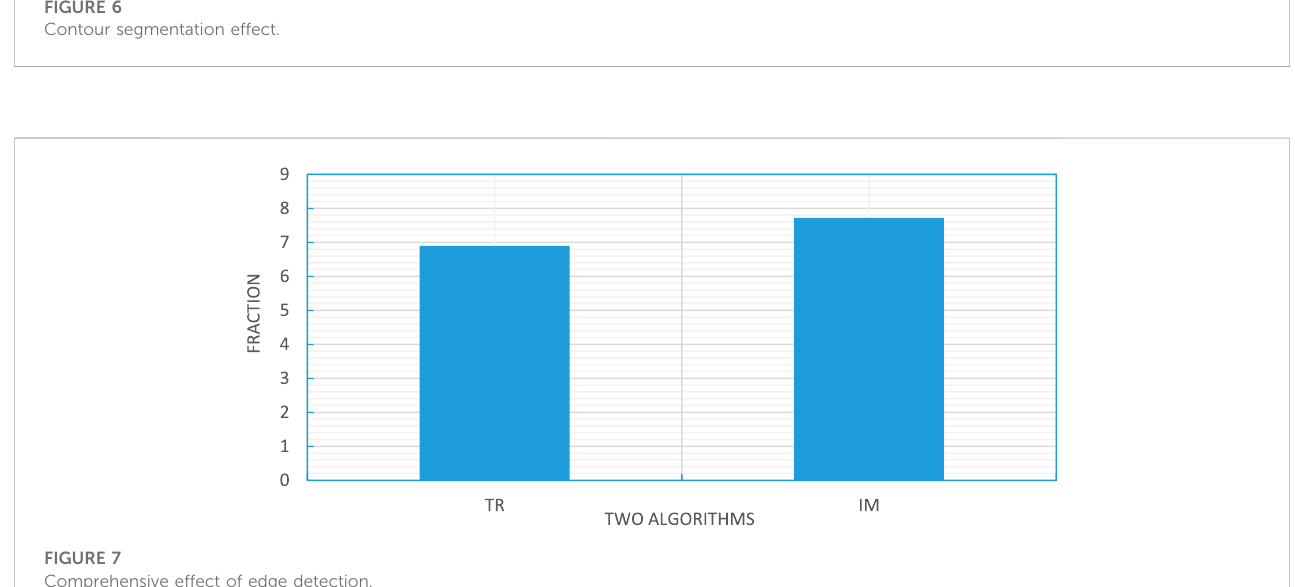
Figure 5 re fl ects the comparison of edge detection accuracy. It